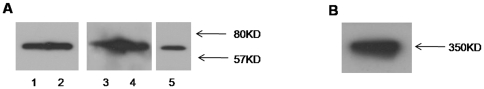
Western blot detection of ostrich IgA.A. IgA expression in tissues and secretions. 1, Large-intestine cytoplasmic proteins; 2, Small-intestine cytoplasmic proteins; 3, Cell membrane proteins of the large intestine; 4, Cell membrane proteins of the small intestine; 5, Large-intestine secretions. B. Dimerized IgA detected in large-intestine secretions.